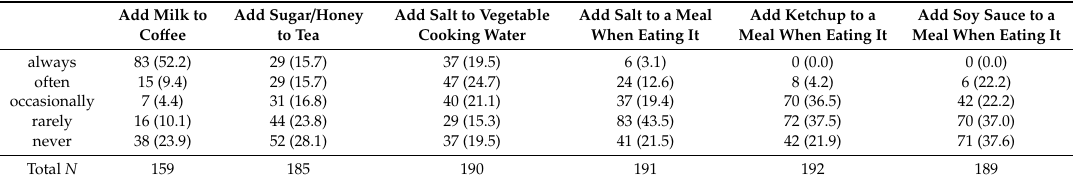
Table 3. Distribution of responses [ N (%)] for habits of masking / modifying